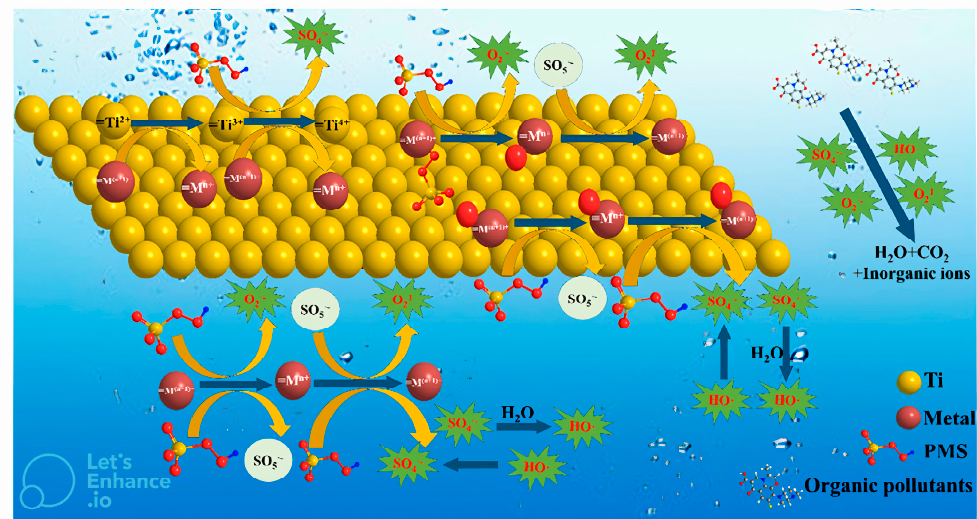
Figure 9. Using MXene-based catalyst and PMS for the decomposing of organic contaminants